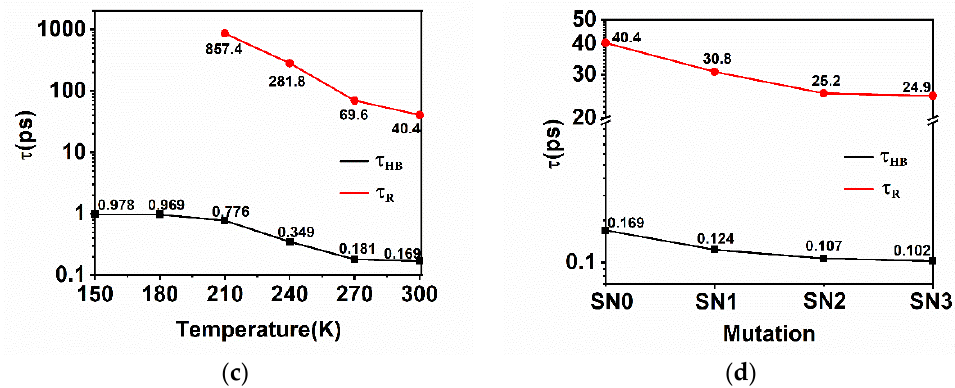
Figure 8. Hydrogen bonds between water and selected regions of the protein: ( a ) hydrogen bond existence autocorrelation function of SN0 at different temperature ( b ) hydrogen bond existence autocorrelation function of different mutations ( c ) hydrogen bond lifetimes τ HB (in black) and relaxation times τ R (in red) of SN0 at different temperatures. ( d ) hydrogen bond lifetimes τ HB (in black) and relaxation times τ R (in red) of different mutations. The calculation methods of the τ HB and the τ R can be seen in the Materials and Methods section.